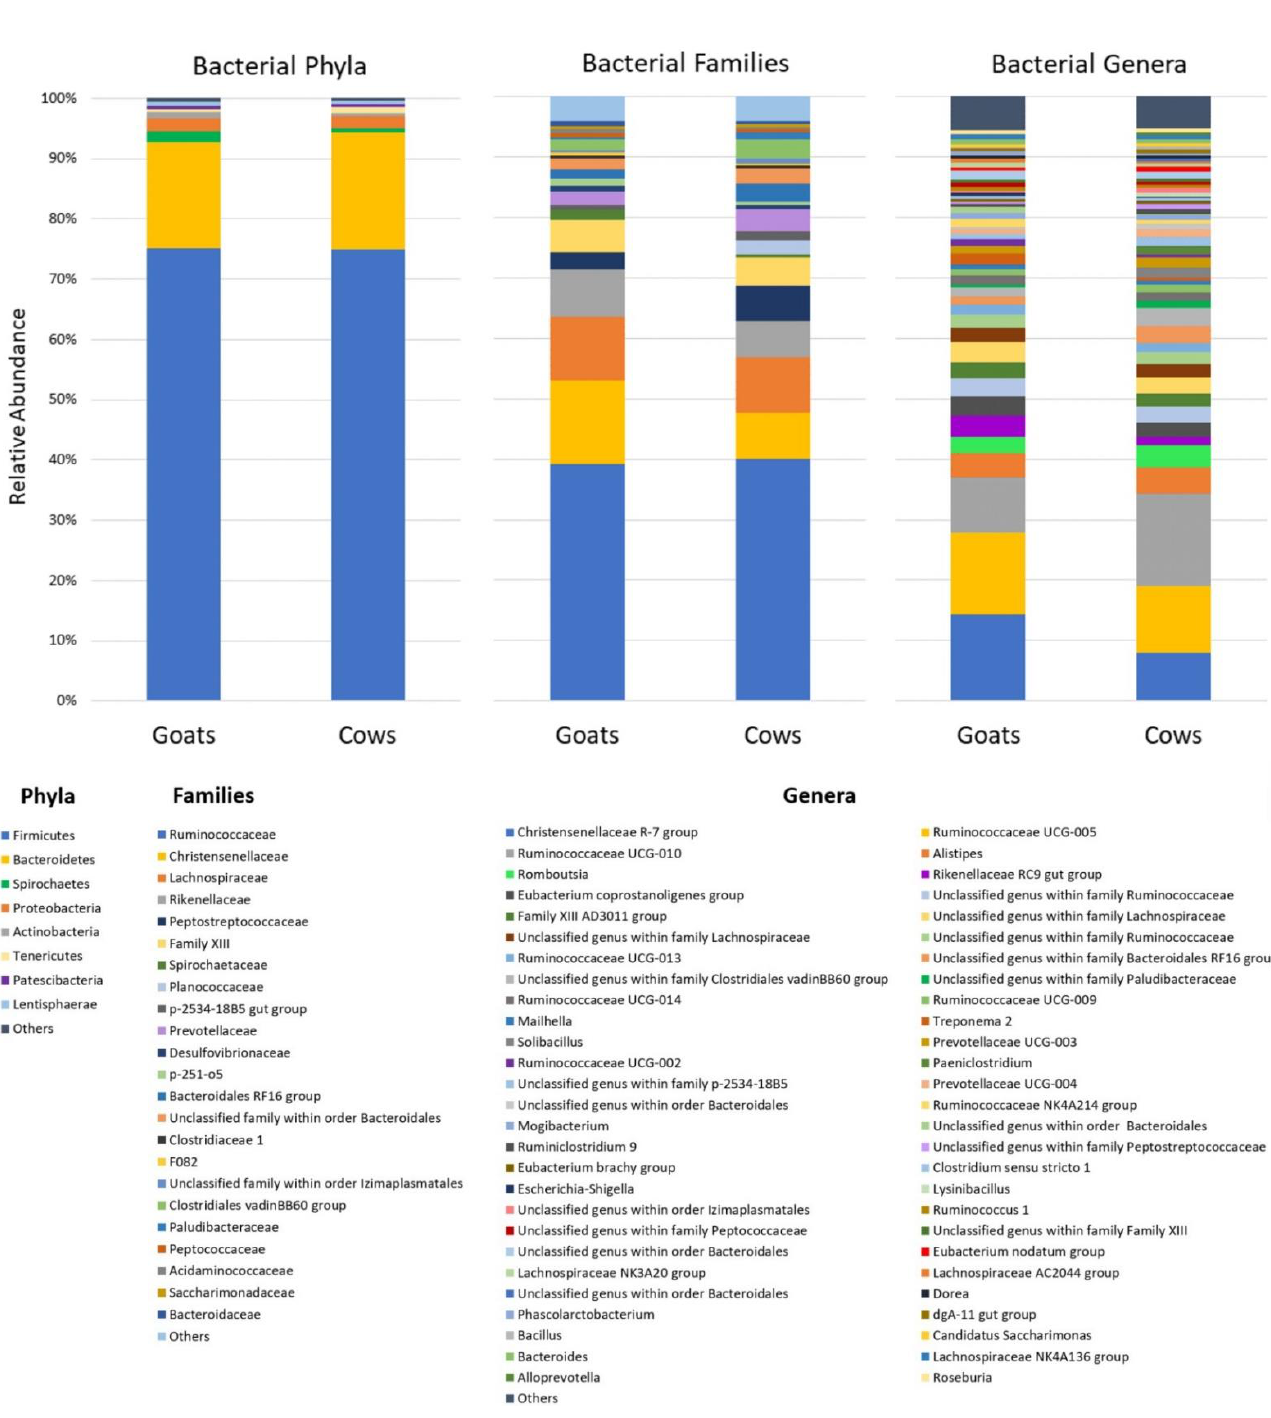
Figure 3. A comparison of the fecal bacteria of goats and cows at several taxonomic levels. The relative abundance is illustrated at the phylum, family, and genus level. Taxa with a relative abundance of less than 0.5% are grouped as "Others".